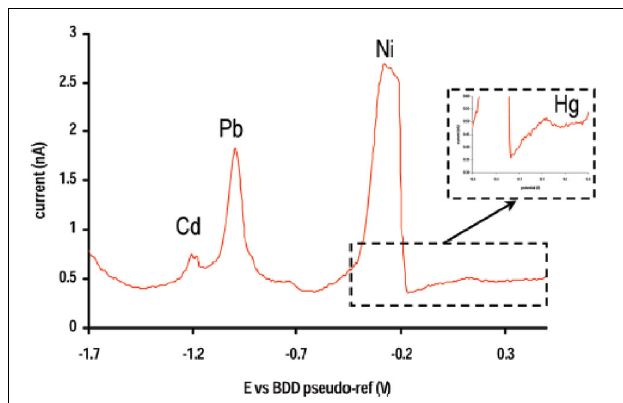
FIGURE 3 | DPASV obtained with a BDD micromachined microcell on a standard solution of Cd (20nM), Ni (38nM), Pb (11nM) and Hg (0.55nM). Reprinted with permission from Sbartai et al. (2012). Copyright 2012 American Chemical